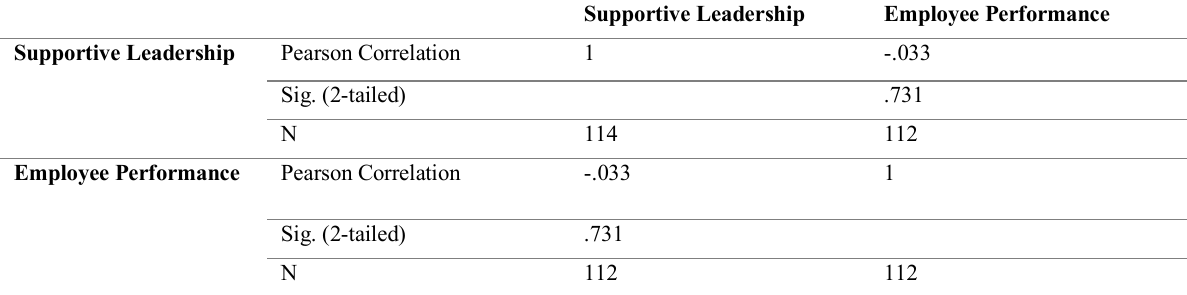
Table 2: Correlation between supportive leadership style and employee performance